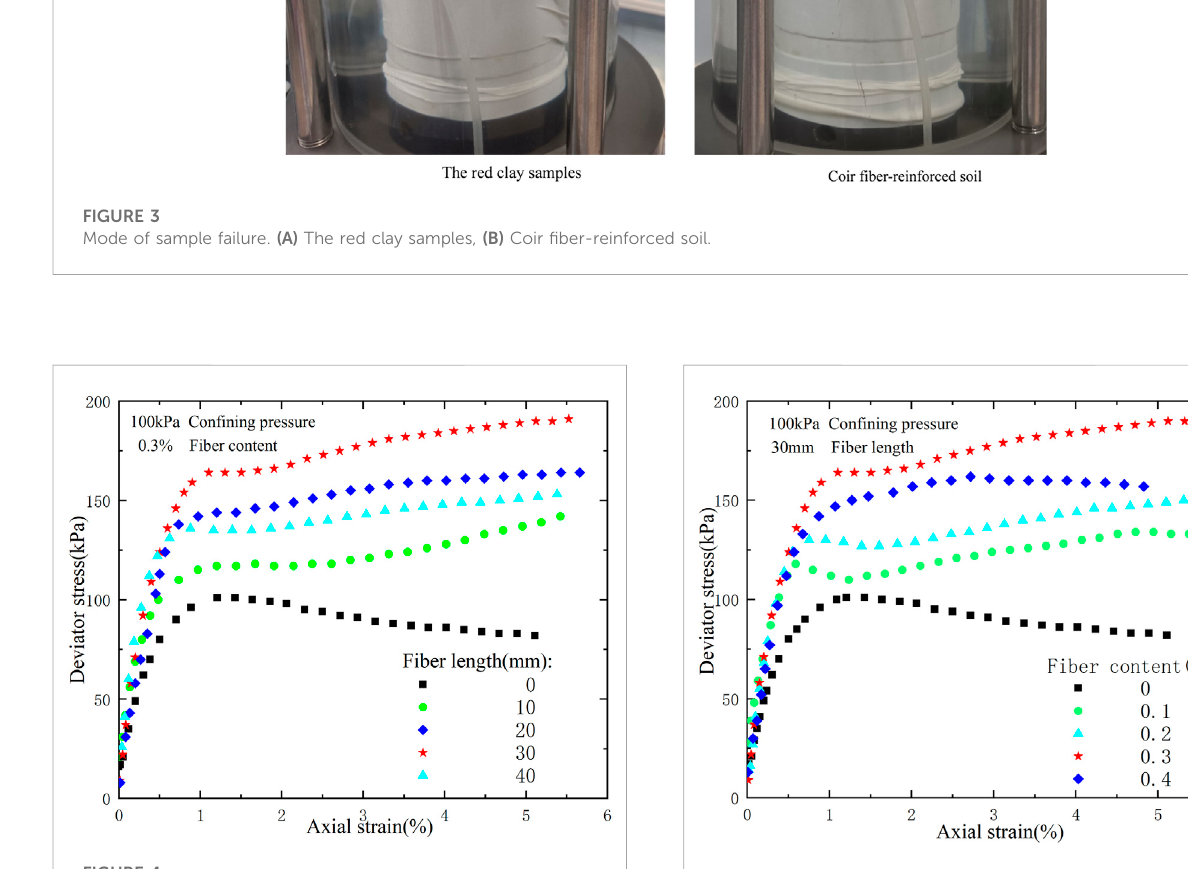
FIGURE 5 Effectonstress-strainofsamplesat0% – 0.4%of fi bercontent at constant con fi ning pressure and fi ber